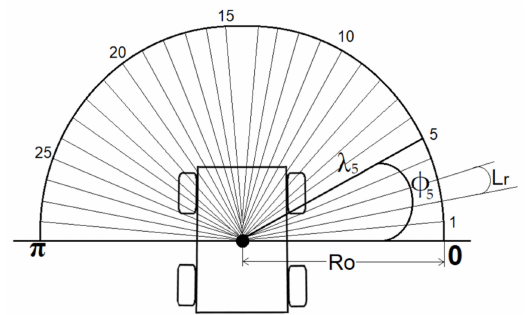
Figure 2. Representation of the Lidar beams on the mobile robot. The actual number of beams is much higher than illustrated here.